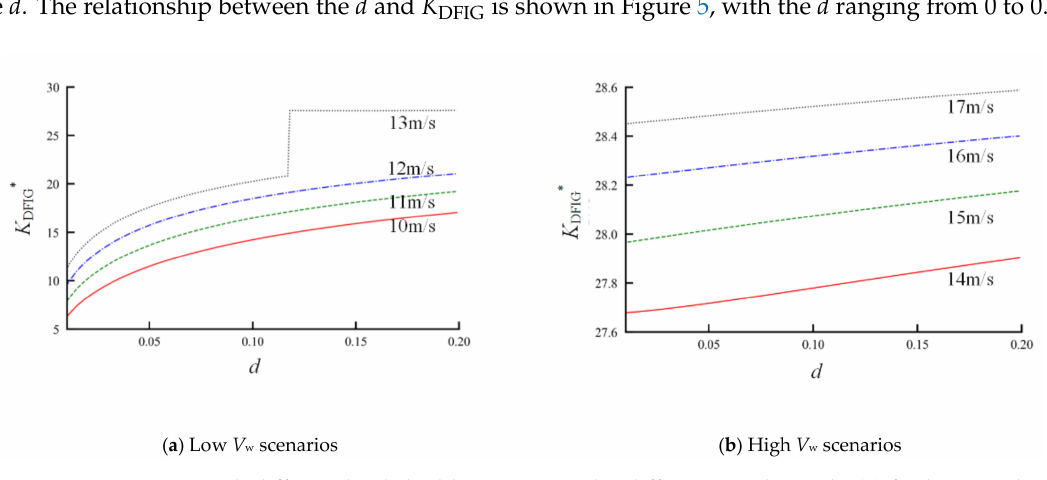
Figure 5. K DFIG * with di ff erent load shedding ratios under di ff erent wind speeds, ( a ) for low wind speeds, ( b ) for high wind